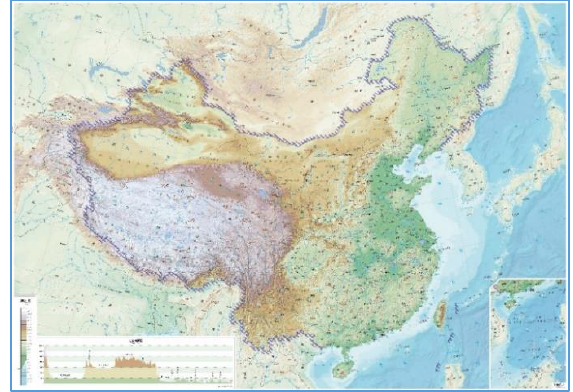
Figure 4. Terrain Map of China in the Atlas 4.3.2 group of topography and terrain maps: Each provincial